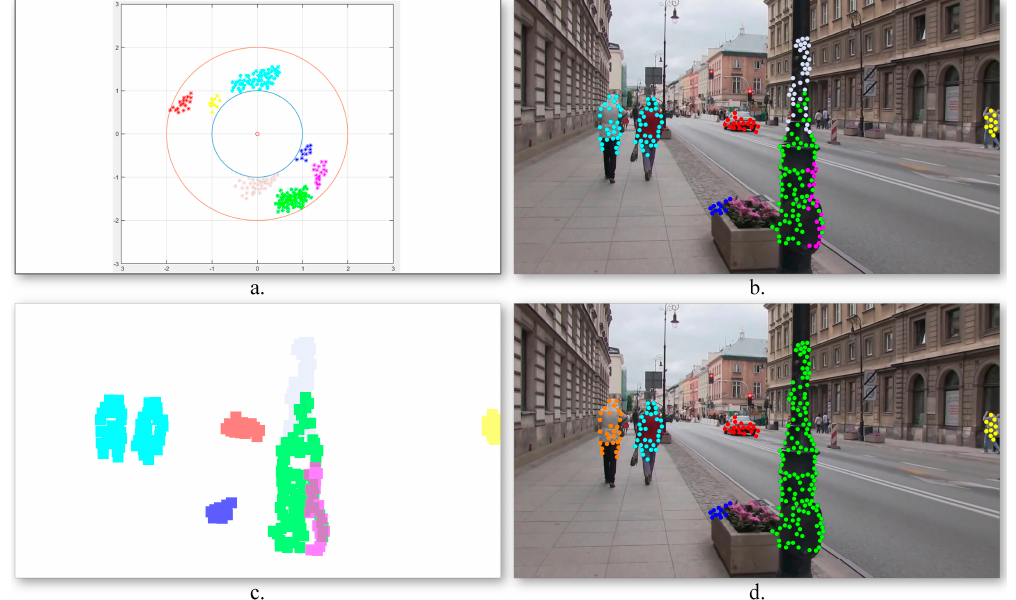
Figure 5. Foreground motion estimation: ( a ) Points of interest distribution in the Cartesian space constrained to lay on an annulus; ( b ) Motion class estimation using k -means clustering; ( c ) Motion cluster binary masks; ( d ) Cluster division/merging based on spatial constraints.